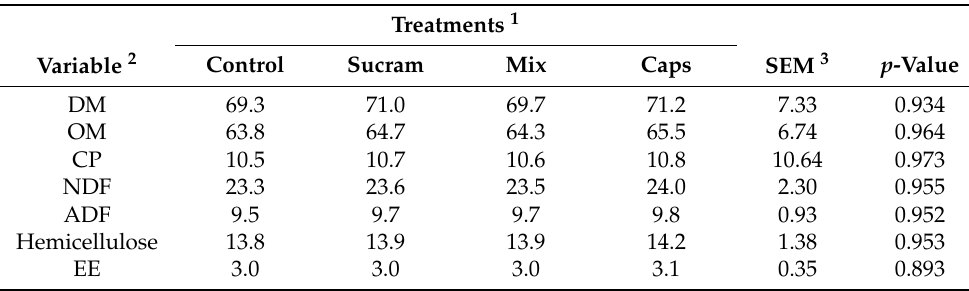
Table 3. Effect of the flavours on daily feed intake expressed in grams per metabolic body weight (g/Kg BW 0.75 ) in lambs.